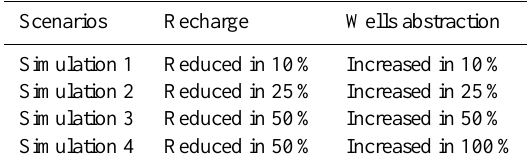
Table 3. Water transfer in the Crocodile catchment. Table 4. Abstractions simulation